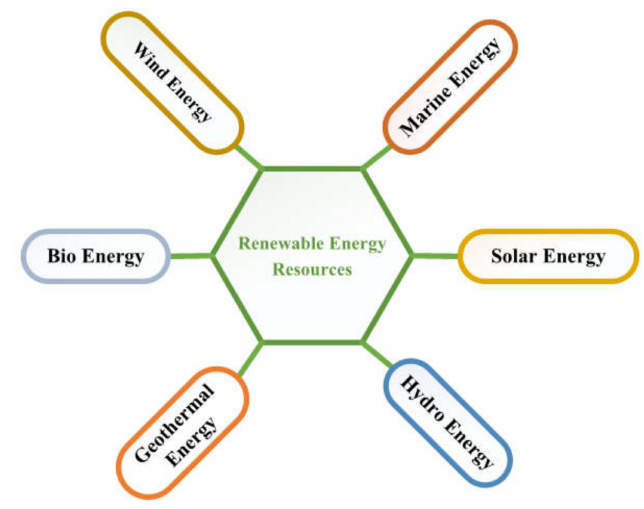
Figure 1. Renewable Energy